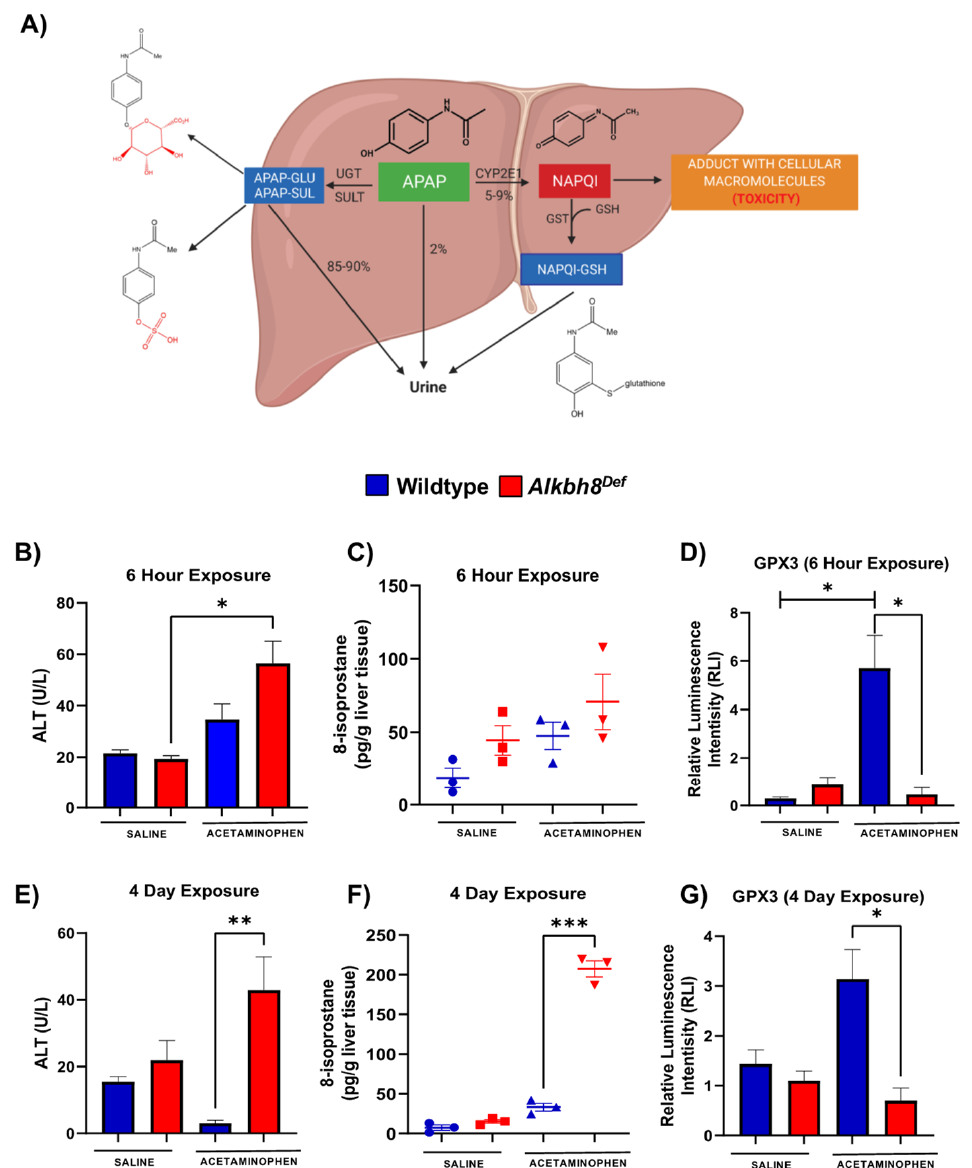
Figure 1. Writer deficient mouse livers have increased sensitivity to APAP induced stress and display decreased selenoprotein levels. ( A ) APAP can be converted into a non-toxic form by UDP- glucuronosyltransferases (UGT) or a toxic form by cytochrome P450 enzyme (CYP2E1) to generate the reactive intermediate metabolite N-actyl-p-benzoquinone imine (NAPQI). Male C57Bl/6 WT (blue) and Alkbh8 Def (red) mice (8–12 weeks old) were exposed to a single dose of APAP ( B – D ) or daily dose of APAP over 4 days ( E – G ), and tissue/blood was harvested. ( B , E ) ALT and ( C , F ) 8-isoprostane levels were determined in blood and liver samples, respectively for WT saline (blue circle), Alkbh8 Def saline (red square), WT APAP (blue triangle) and Alkbh8 Def APAP (red triangle) ( D , G ) Gpx3 protein levels in the liver were evaluated using the ProteinSimple WES system. Statistical significance (N = 3) was measured by an unpaired t -test with (* p < 0.05, ** p < 0.01, and *** p < 0.001).